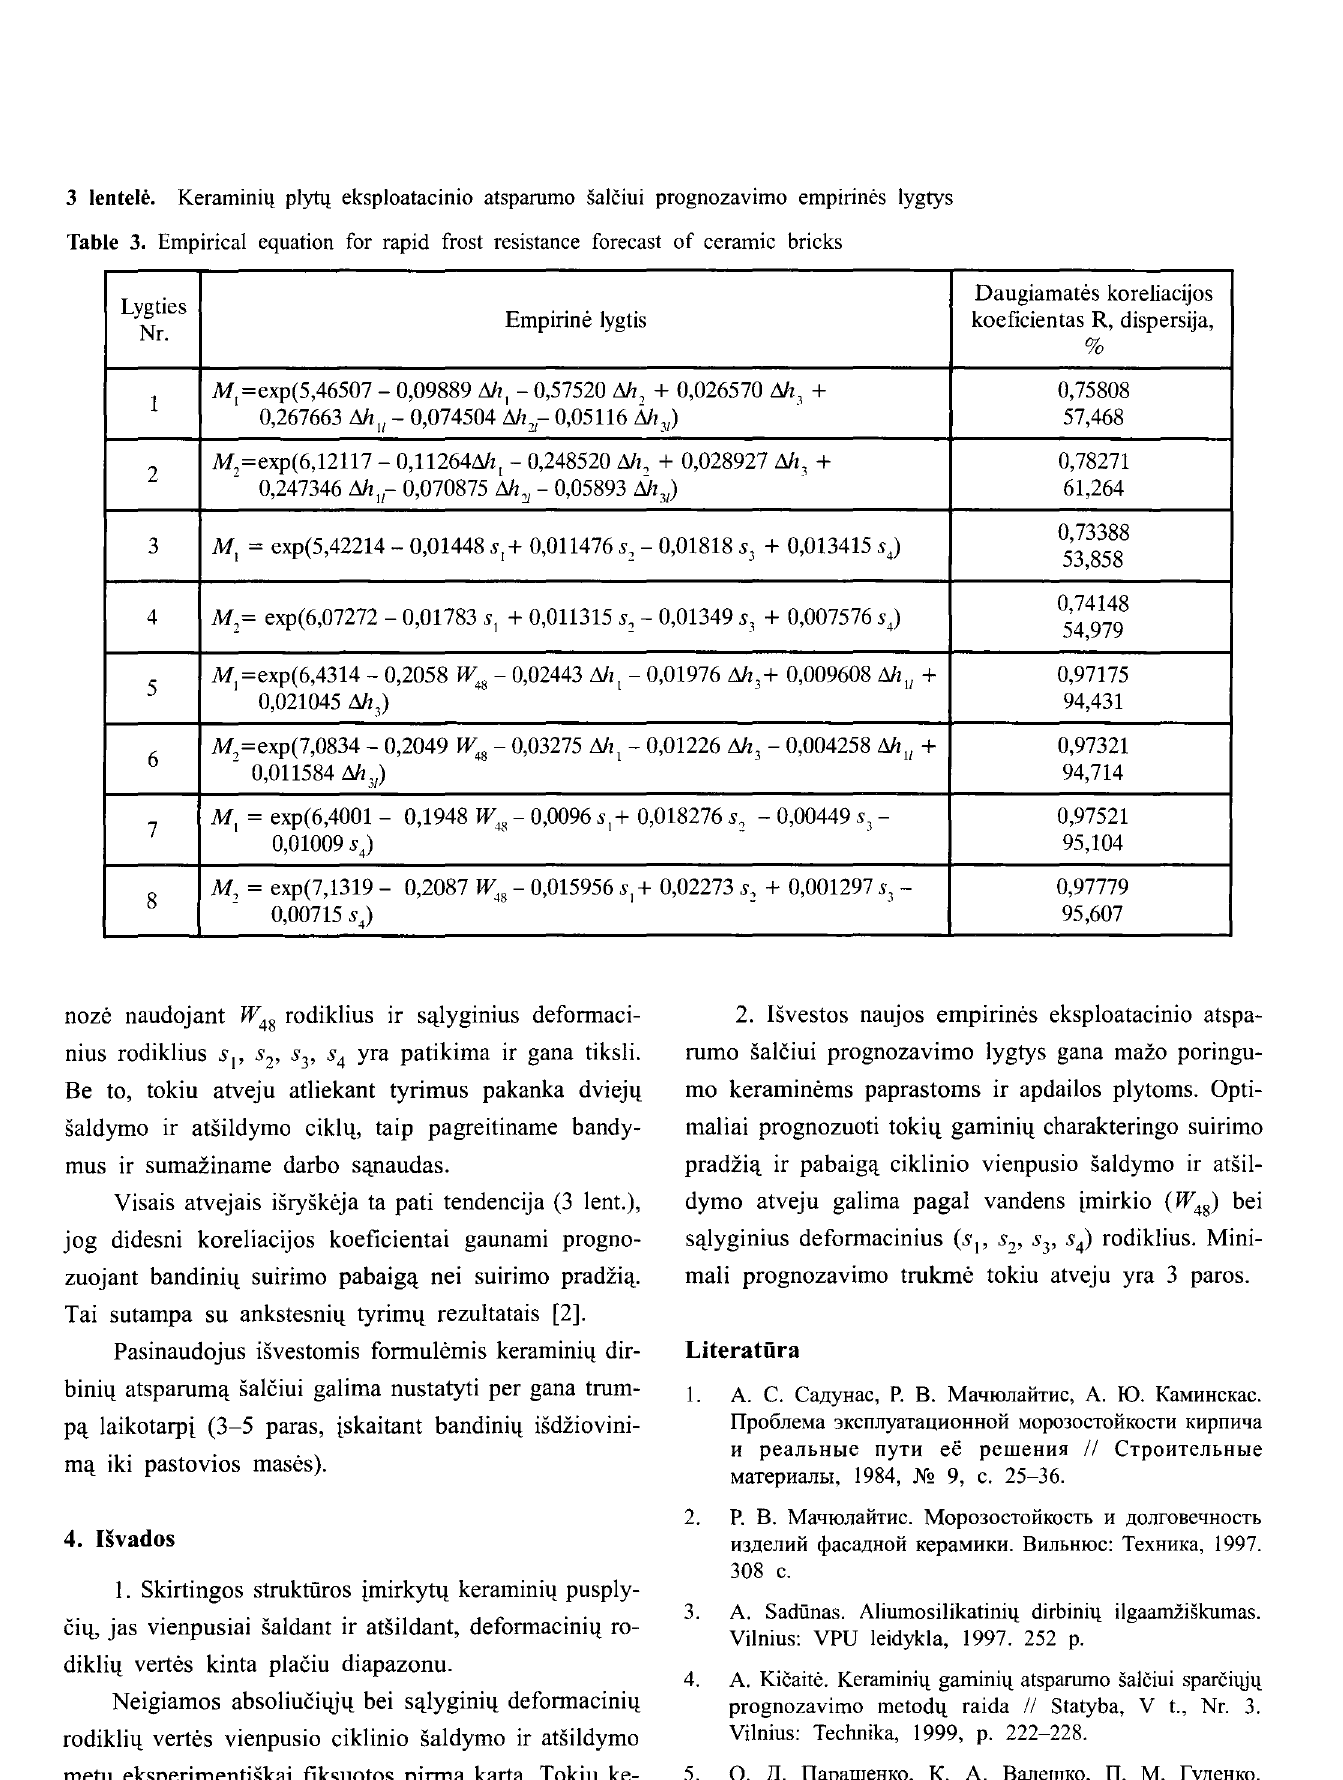
Table 3. Empirical equation for rapid frost resistance forecast of ceramic bricks Lygties Nr.